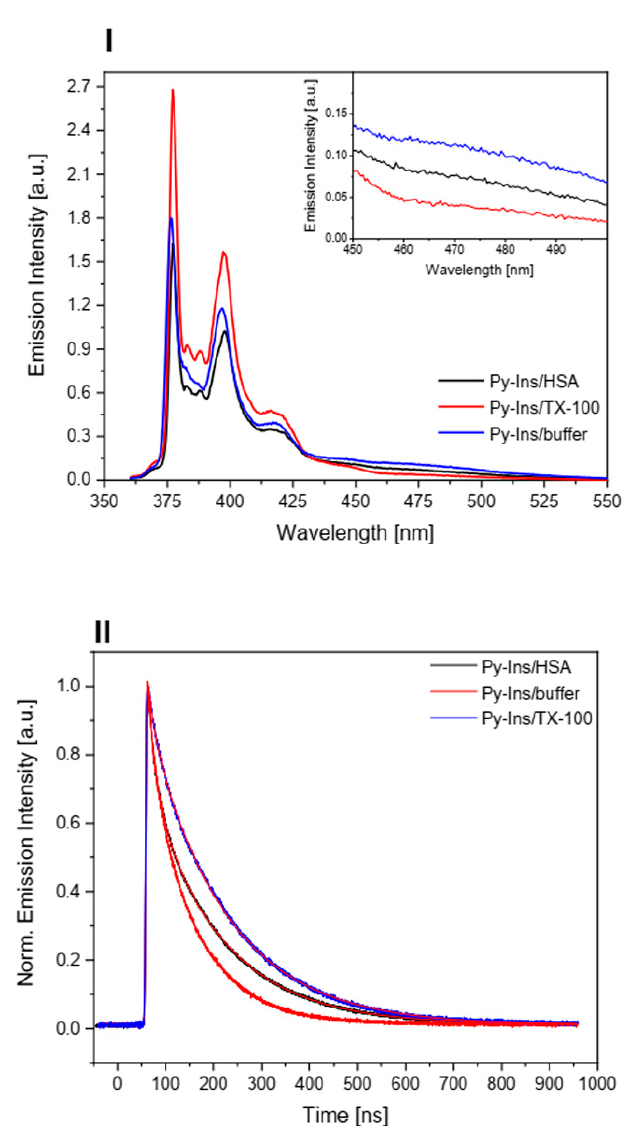
Figure 3. Panel I: Fluorescence spectra of Py-Ins ( 1 ) in aqueous buffer solution and in the presence of TX-100 or HSA. [Py-Ins] = 16.38 µM, [TX-100] = 20 mM, [HSA] = 30 µM, λ exc = 337 nm. Inset: the same spectra in the range of 450–500 nm. Panel II: Normalized decays of Py-Ins ( 1 ) fluorescence in PBS, TX-100, and HSA. [Py-Ins] = 16.38 µM, [TX-100] = 20 mM, [HSA] = 30 µM, λ exc = 337 nm, λ em = 405 nm. See Table 1 for parameters of the best-fit lines (smooth).